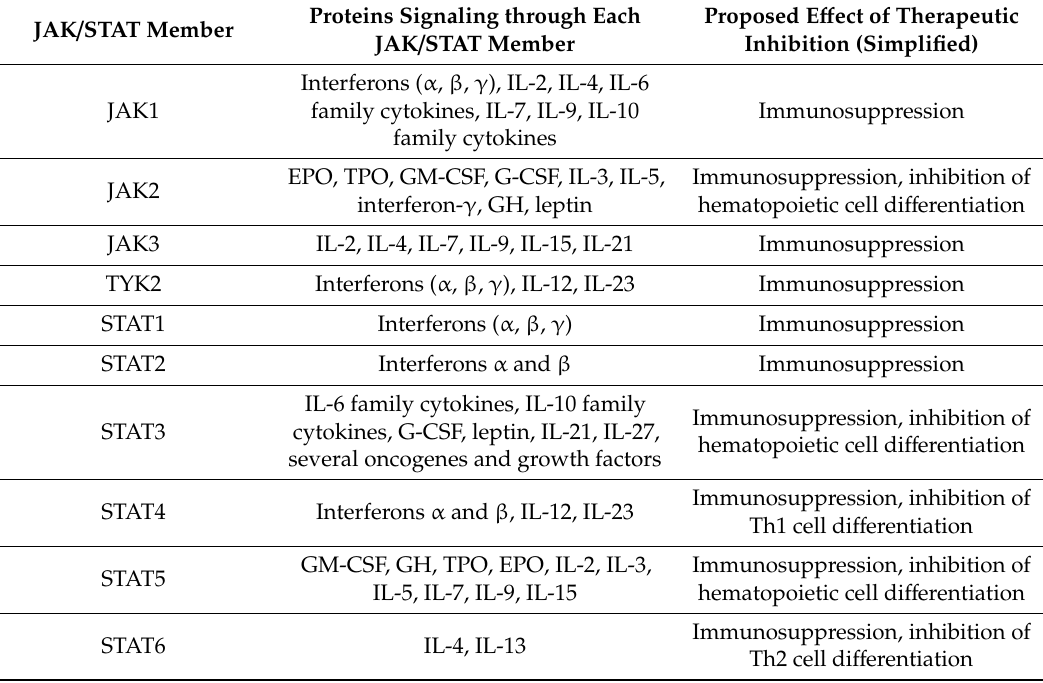
Table 1. Member proteins of the JAK / STAT system and upstream molecules, which signal via the respective